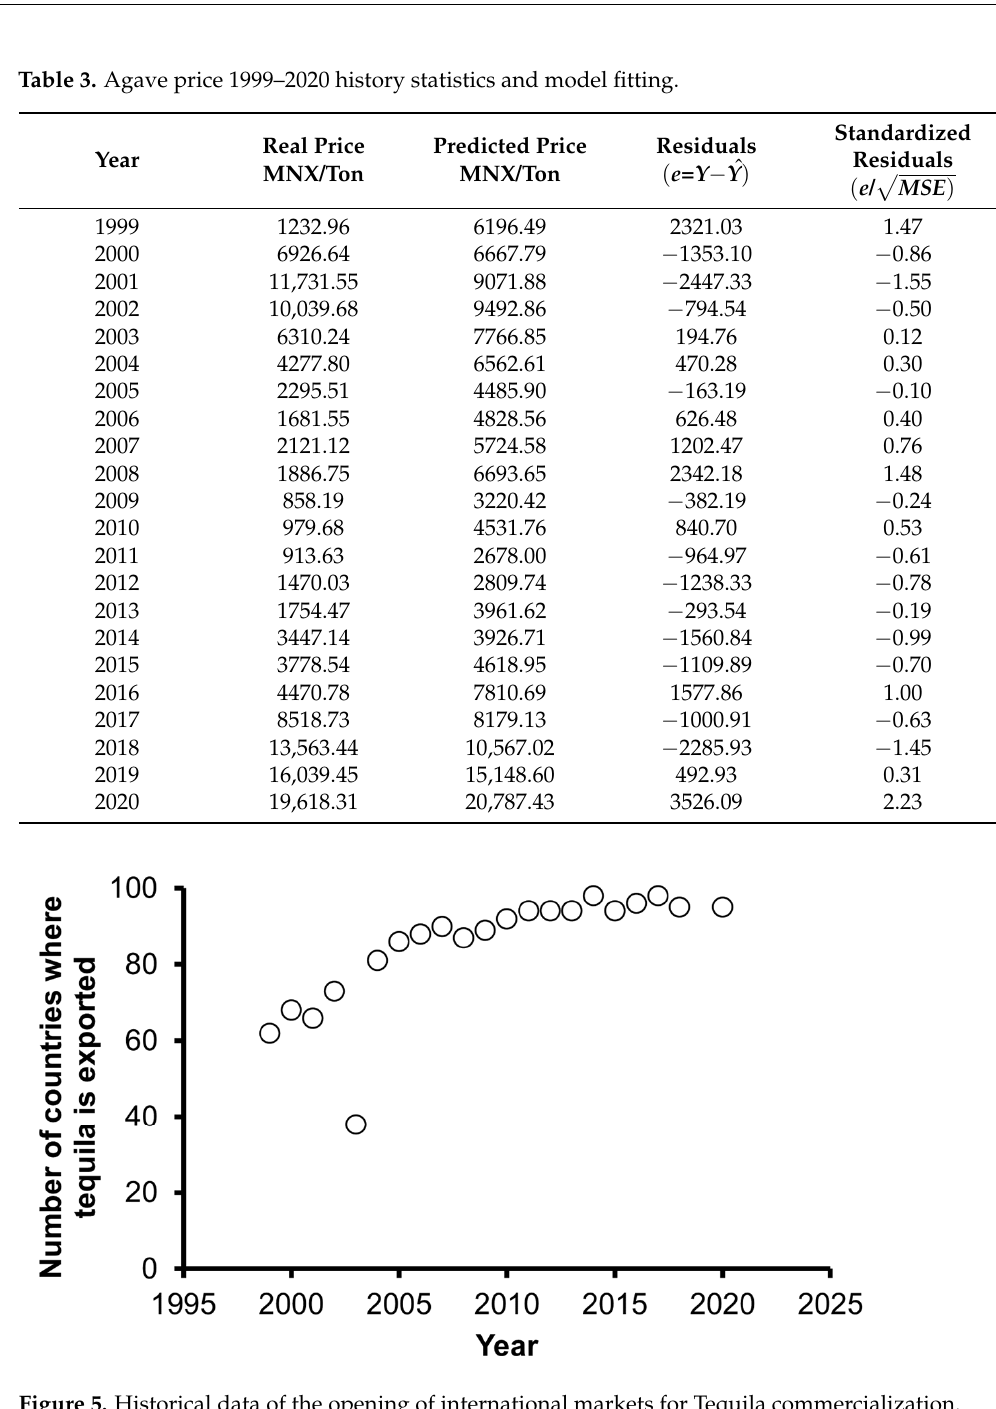
Figure 5. Historical data of the opening of international markets for Tequila commercialization. Table 4. Tequila sales participation percentage in the international markets from 2020.